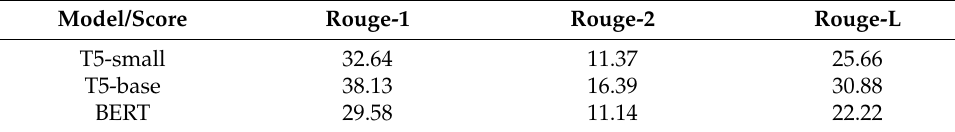
Table 5. Performance evaluation (using complete training data).